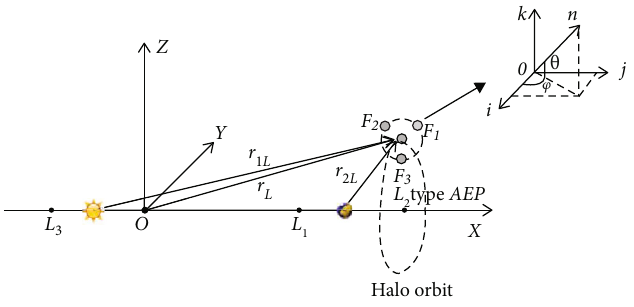
Figure 1: Relevant coordinate systems.